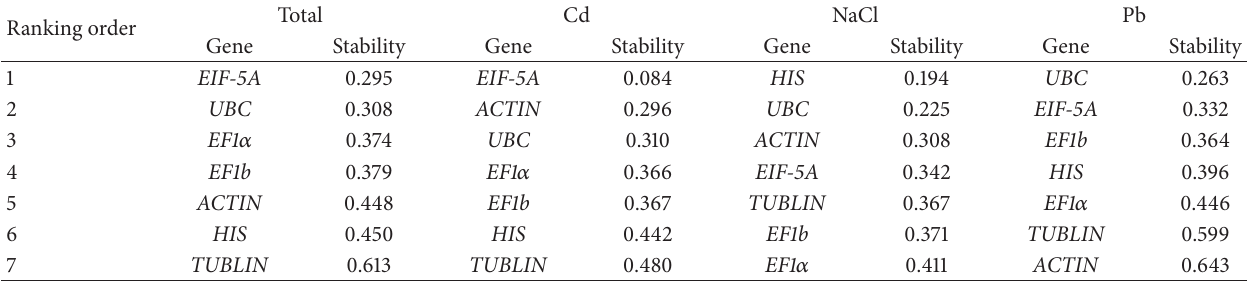
Table 3: Ranking of seven reference genes in order of their expression stability calculated by NormFinder. Ranking